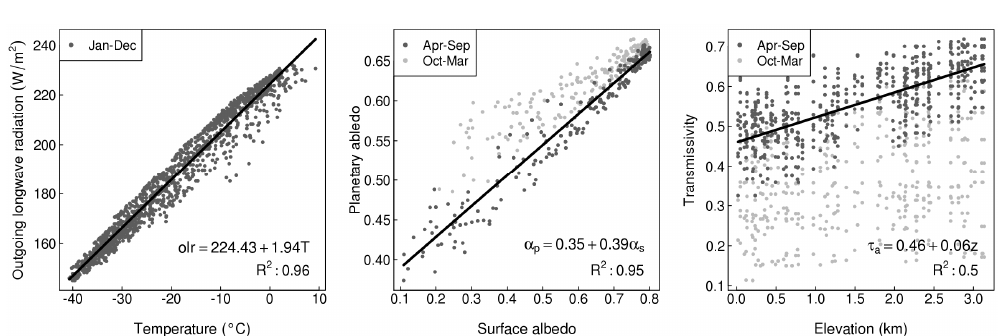
Figure 1. (a) Monthly ERA-40 data of outgoing long-wave radiative flux versus temperature, shown with a linear fit to all data. Monthly ISCCP data, April–September (dark points) and October–March (light points), of (b) planetary albedo versus surface albedo with a linear fit to the months April–September, and (c) transmissivity versus elevation with a linear fit to the months April–September. All points are from data over Greenland.